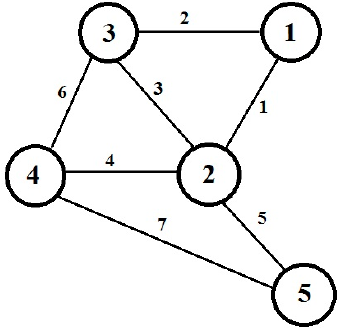
Figure 6. Representative direct graph of the five-bus network.